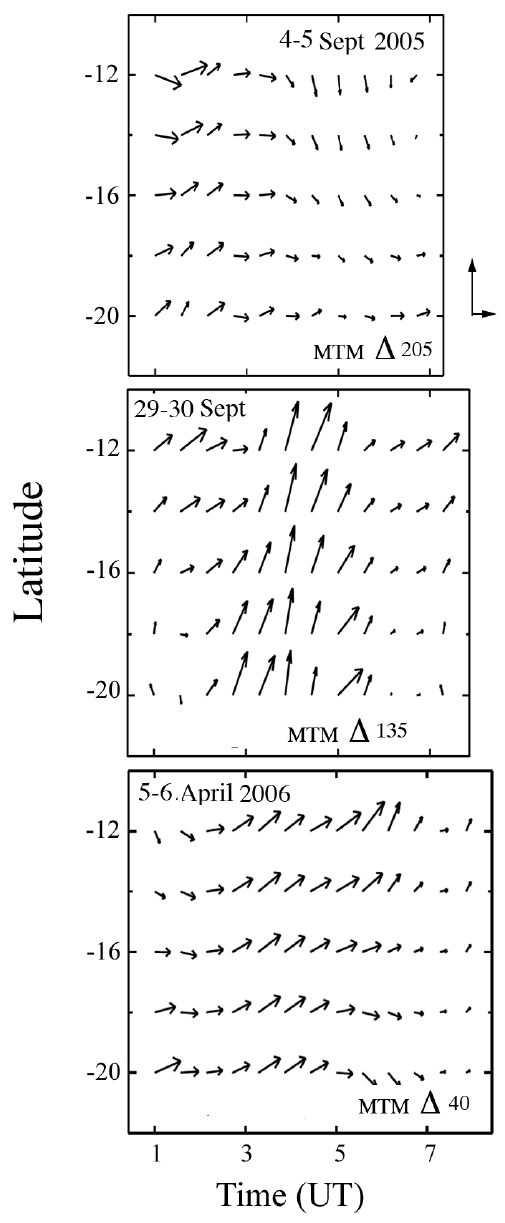
Fig. 9. Horizontal wind maps for the three nights of Fig. 8: 4– 5 September 2005, 29–30 September 2005, and 5–6 April 2006. Local midnight occurs at 05:00UT. The horizonal meridional or zonal wind speed of 100ms − 1 is represented by the distance of 2 ◦ latitude or 30min, respectively. The time and the magnitude of the MTM peak are indicated by the triangle next to the MTM label and the number,